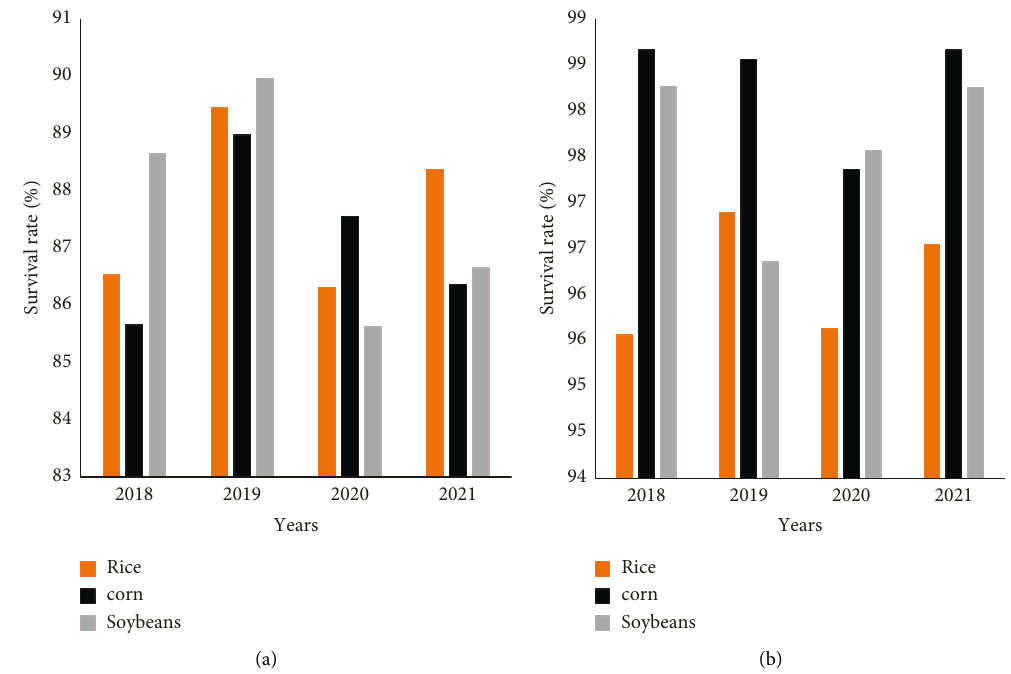
Figure 5: Survival rate of traditional crops and synthetic crops in different